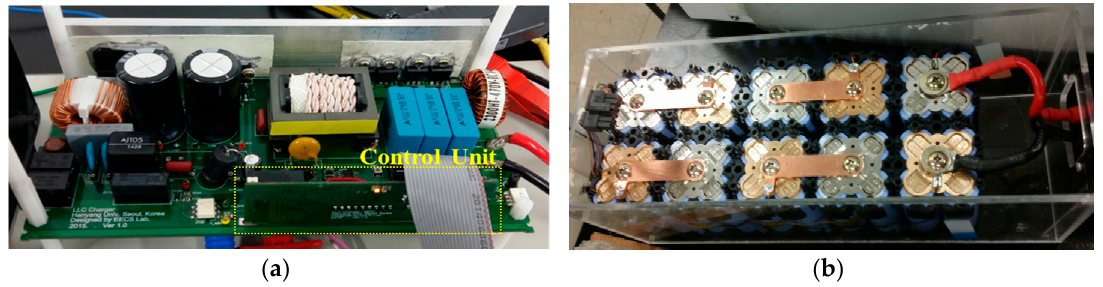
Figure 12. Experimental setup: ( a ) LLC resonant battery charger, ( b ) Li-ion battery pack.